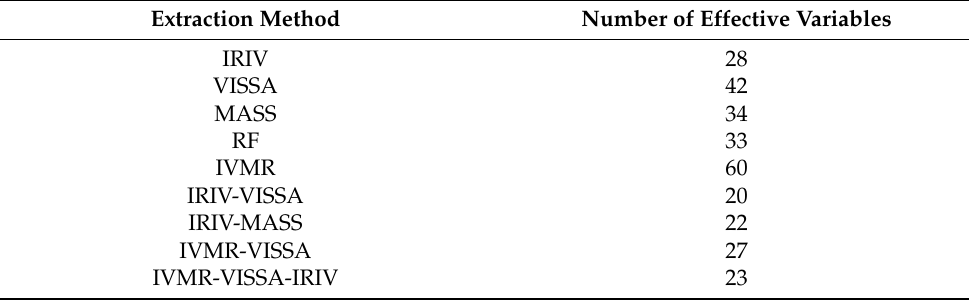
Table 4. The numbers of effective variables extracted by different